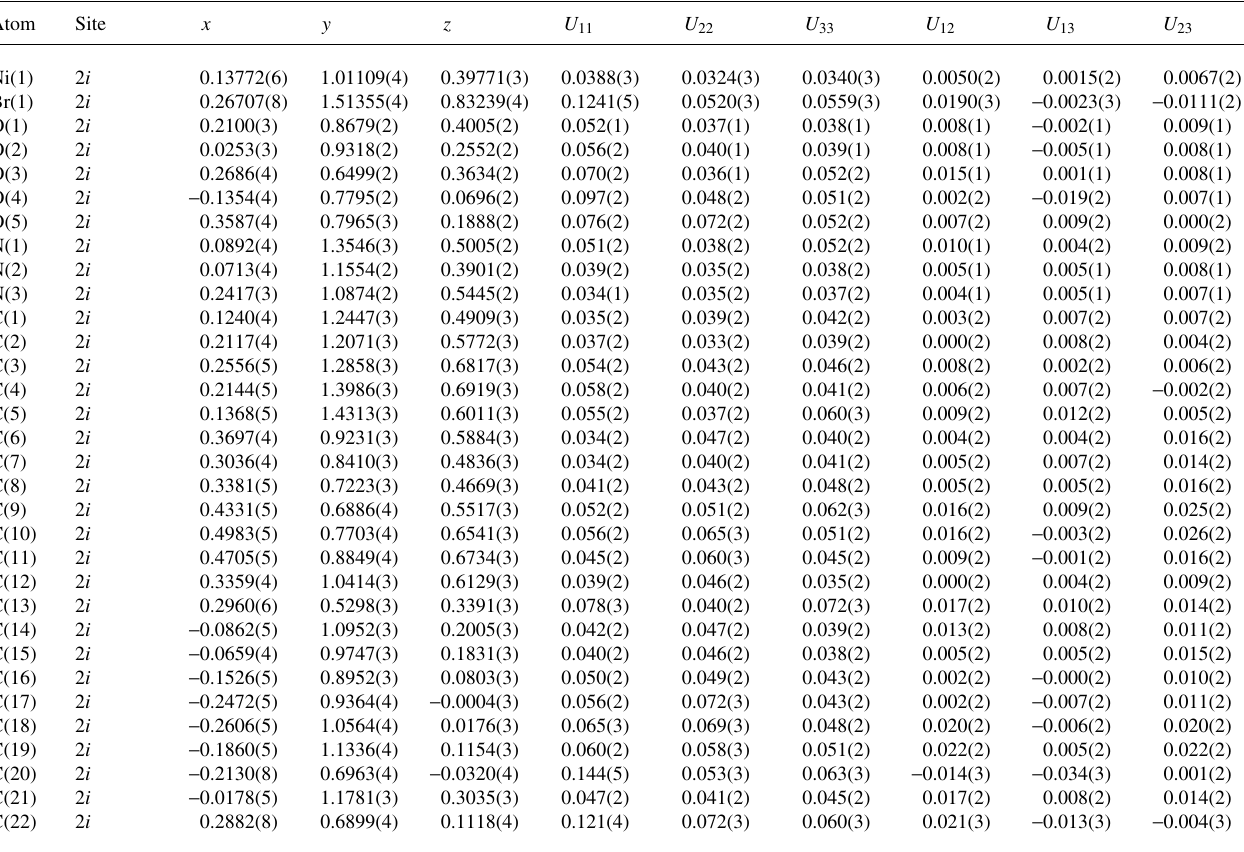
Table 3. Atomic coordinates and displacement parameters (in Å 2 )